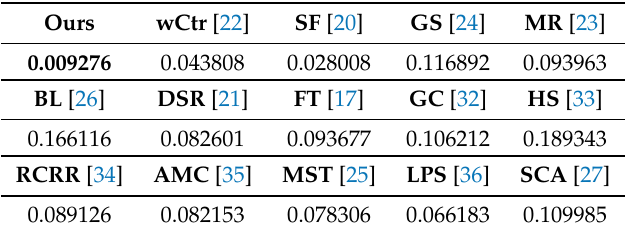
Figure 7. The result of the P–R curve and F-measure in the experiment. Table 1. The MAE